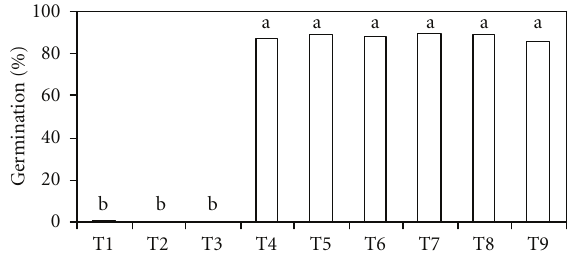
Figure 1: Germination of Ormosia arborea seeds submitted to di ff erent dormancy breaking treatments. T 1 : control; T 2 : immersion in 100 ◦ C water; T 3 : immersion in boiling water followed by 24h of soaking; T 4 and T 5 : scarification with number 100 and number 50 sandpaper, respectively; T 6 , T 7 , T 8 , and T 9 : immersion in sulfuric acid for 1 hour, 50min, 45min, and 30min, respectively.